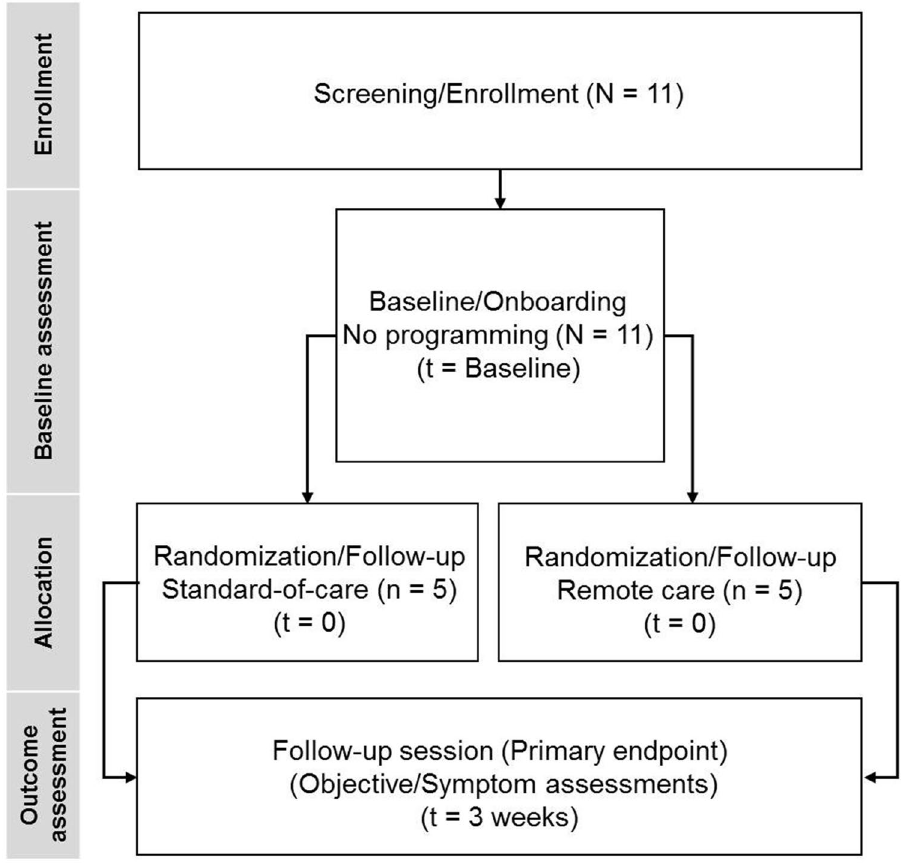
Figure 2. Flow diagram of the study